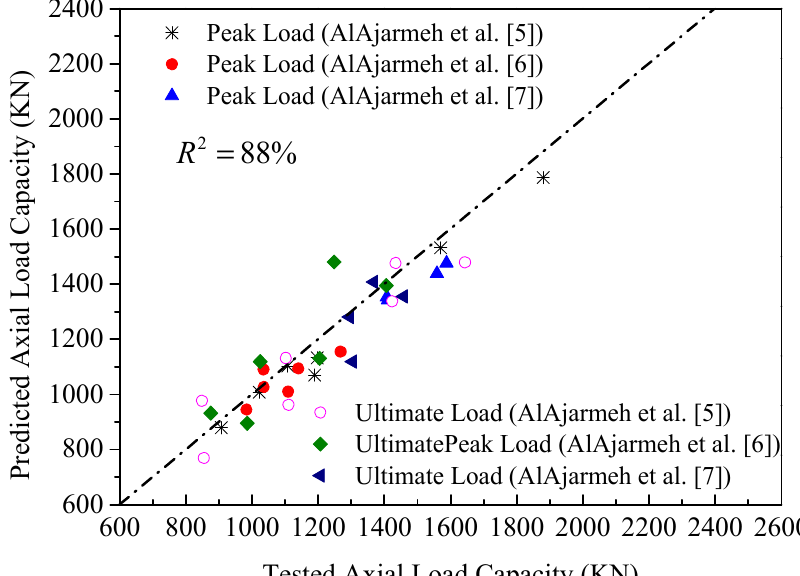
Figure 14. Comparison of tested and numerically obtained first and second axial peak capacities of HCCs.